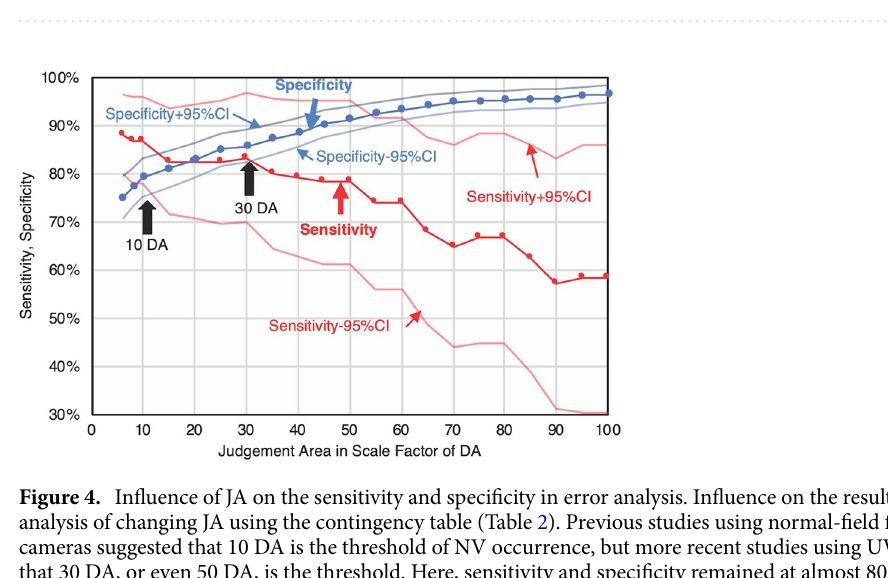
Figure 3. Bias and 95% CI for interobserver variation. Annotator B was the main annotator and closest to the eNPA.